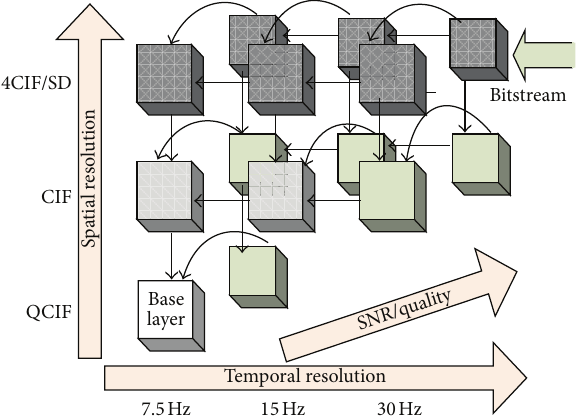
Figure 1: Schematic representation of the SVC bitstream: the spatial and/or temporal resolution is increased with the increase of a layer index(thebase-layer(Layer0),Layer1,Layer2,etc.),whiletheBase- Layer has the lowest bitstream resolution [3].